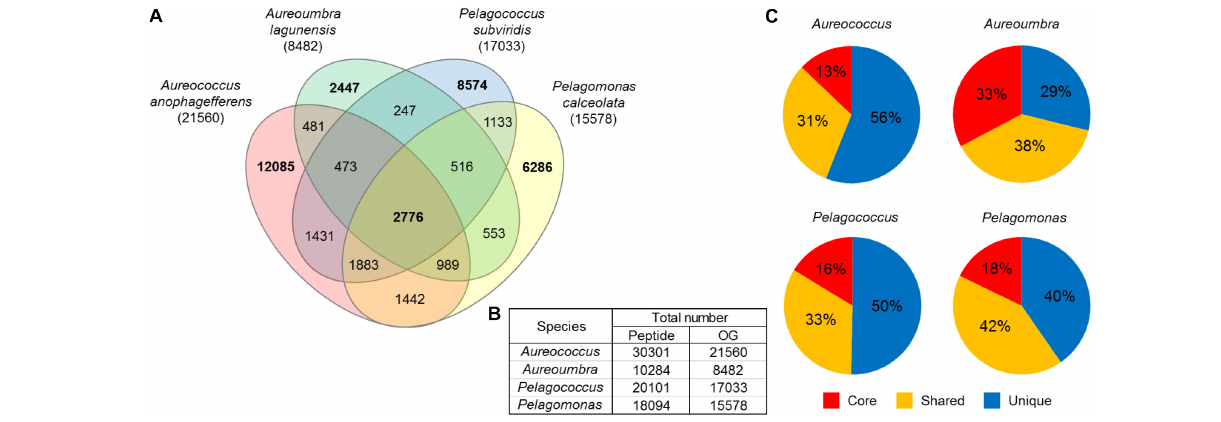
FIGURE 2 | (A) Venn diagram displaying the number of core, shared, and unique OGs among the four pelagophytes where bold numbers are unique and core OGs, (B) the number of peptide sequences that were used for OrthoMCL analysis and the number of OGs after the analysis, and (C) the proportion of core (red), shared (yellow), and unique (blue) OGs in each species. Core OGs were found in all four species, shared OGs were expressed in two or three of the four species, and unique OGs were expressed in a single